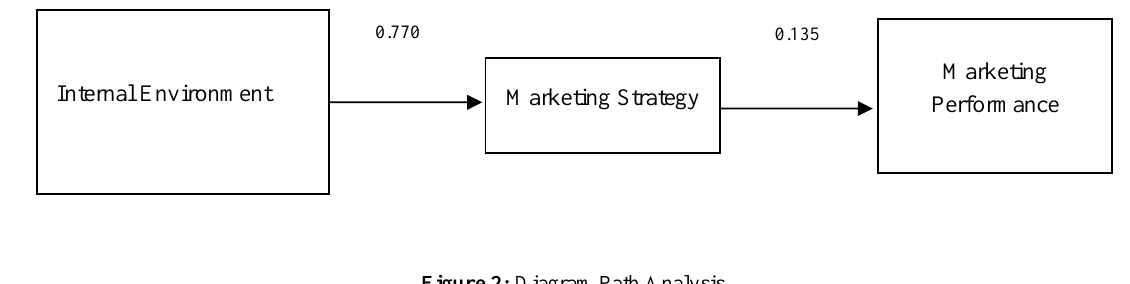
Figure 2: Diagram Path